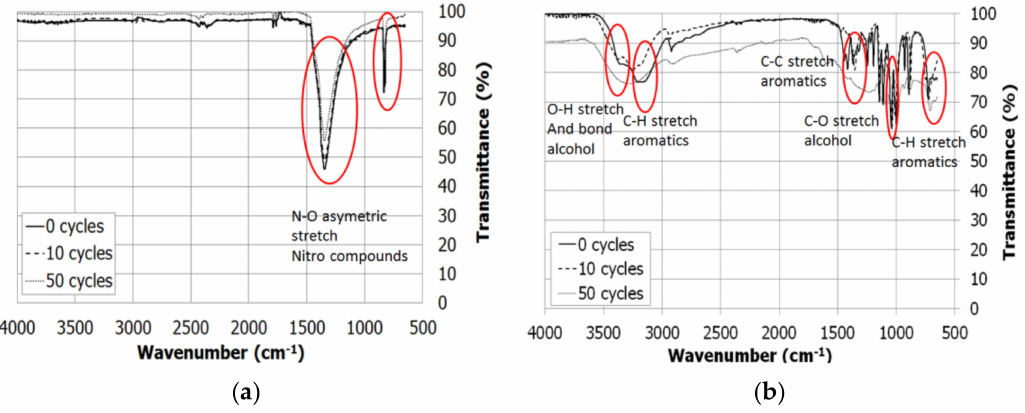
Figure 3. Infrared attenuated total reflectance (IR-ATR) spectrums after 0, 10, and 50 thermal cycles of ( a ) solar salt; and ( b )